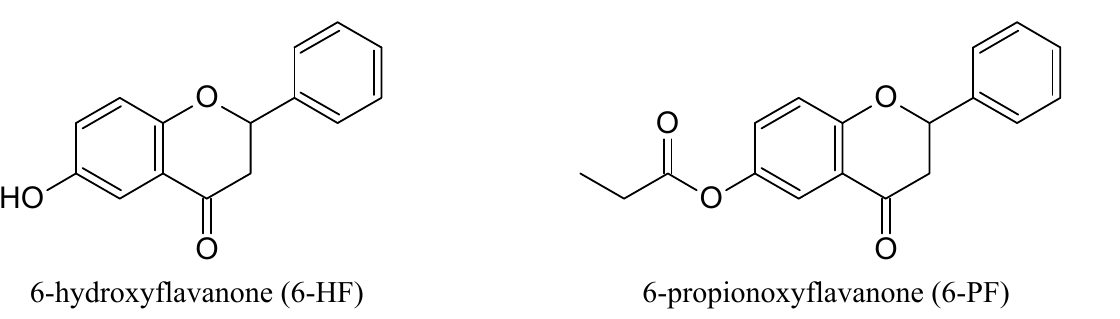
Figure 1. Chemical structures of tested synthetic